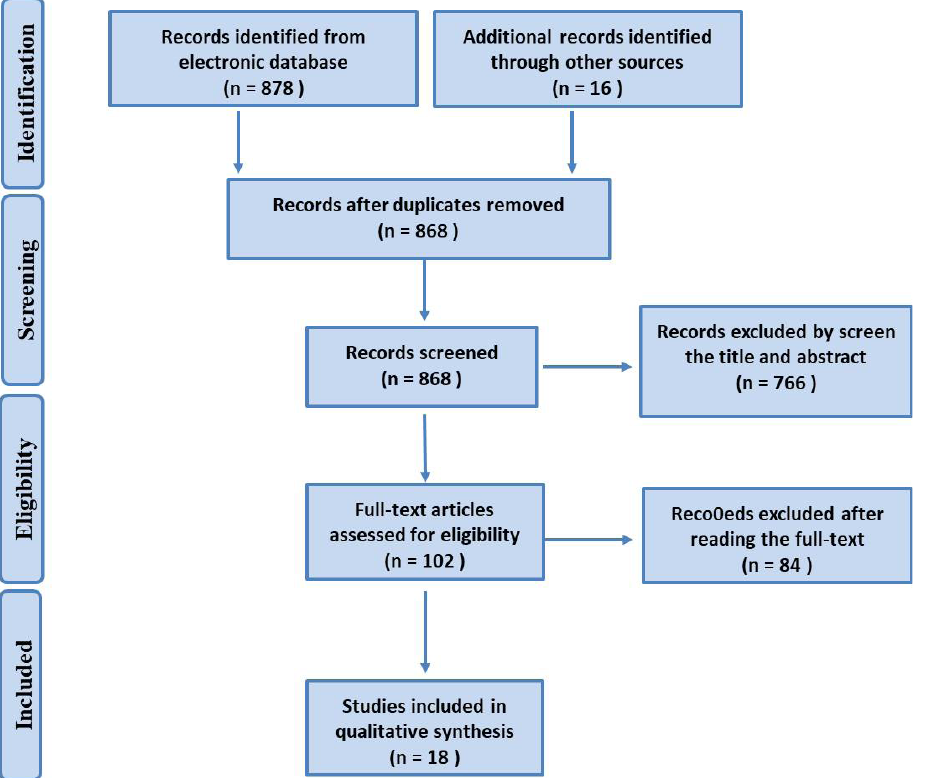
Figure 1: The publication searching flow